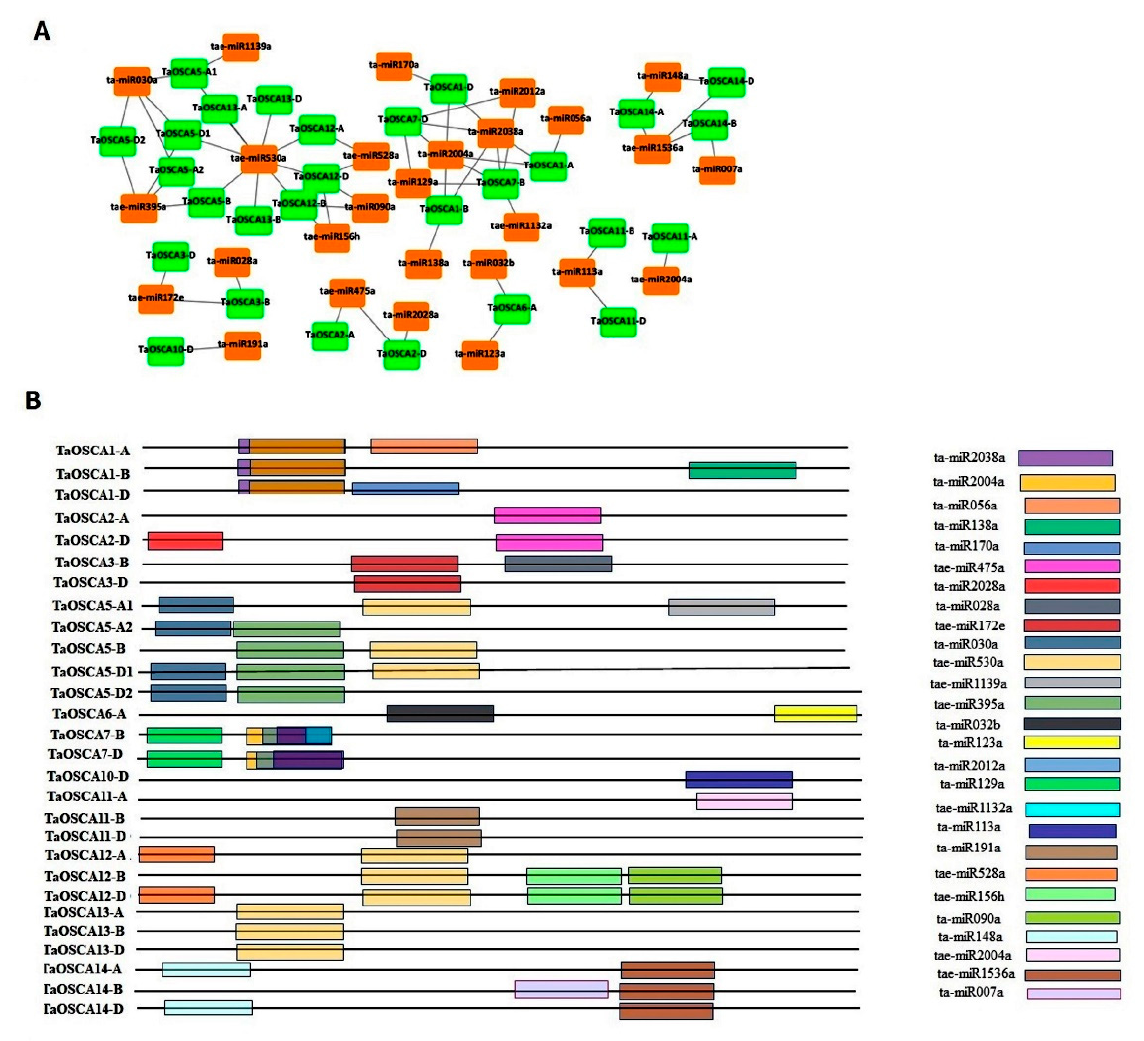
Figure 8. miRNA interaction analysis. The interaction network ( A ) of known miRNA of T. aestivum with TaOSCA genes. The prediction and generation of the network were performed by psRNAtarget tool and Cytoscape software, respectively. Figure 8 ( B ) shows the arrangement of miRNA target sites on TaOSCA genes. The colored boxes represent the predicted miRNAs of T. aestivum.